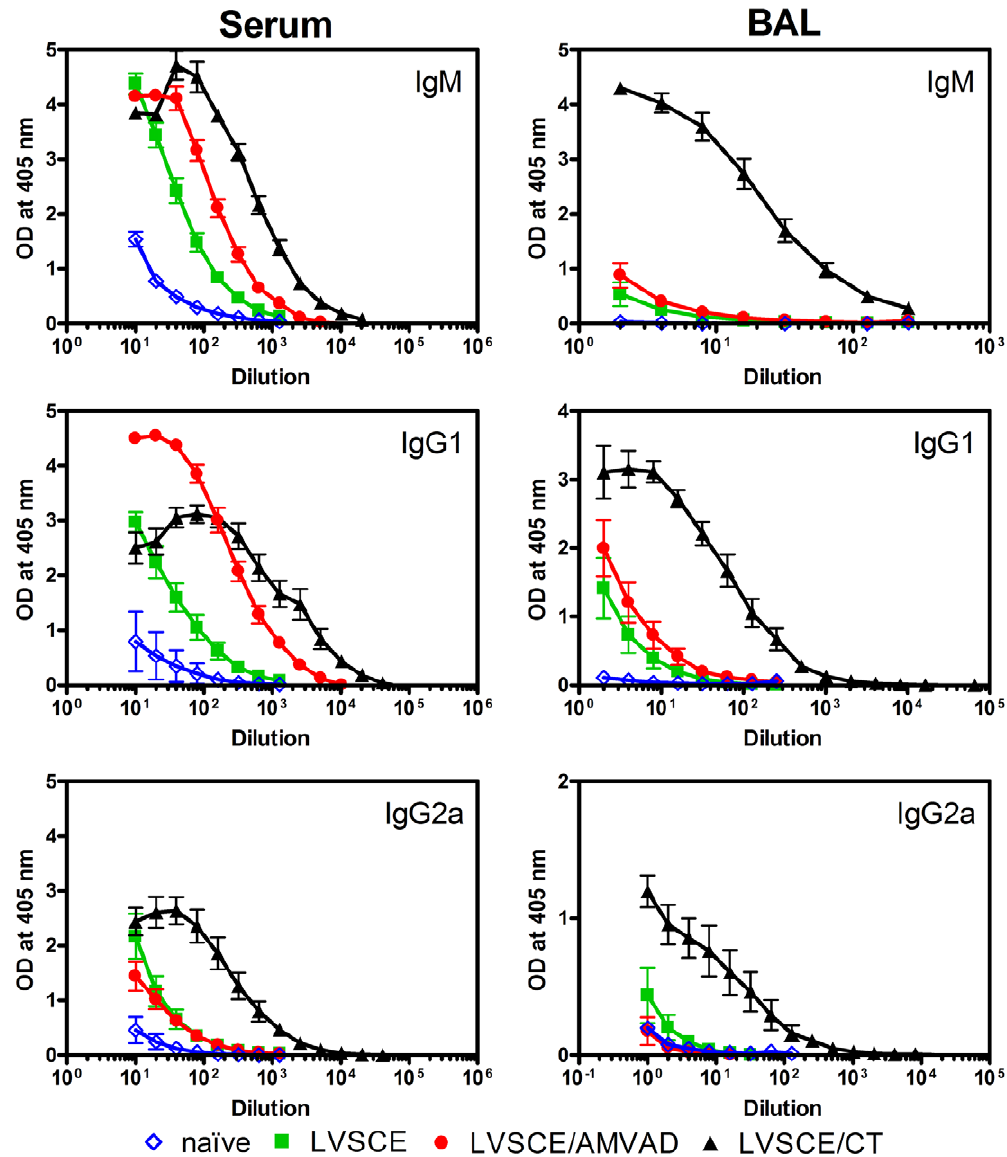
Figure 2. LVSCE/AMVAD vaccine induces strong LVSCE-specific IgM, IgG1 and IgG2a levels in sera and BAL fluids. The sera and BAL fluids collected at 28 d from the naı¨ve, and LVSCE, LVSCE/AMVAD or LVSCE/CT immunized groups of mice in Figure 1 were analyzed for the indicated LVSCE-specific antibody by ELISA. Each data point represents the mean OD 6 SD for each group (n=5). Data are representative of two separate experiments.